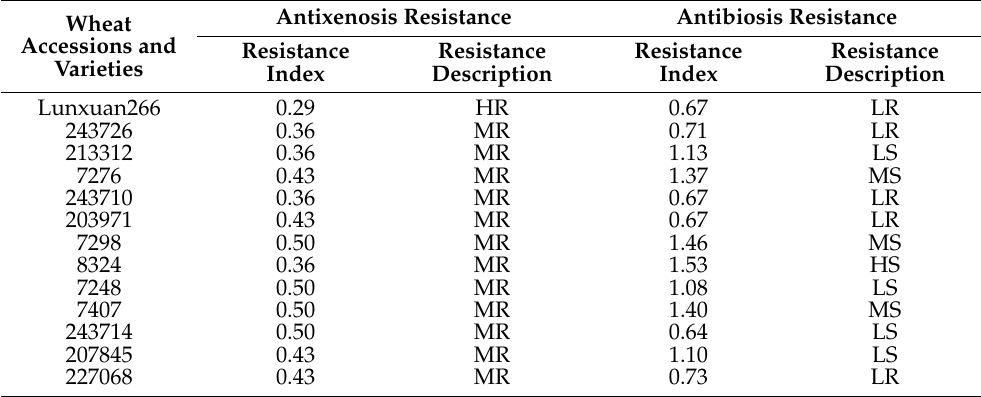
Table 2. Antixenosis and antibiosis resistance index to S. miscanthi for thirteen wheat accessions and varieties. Antixenosis Wheat Accessions and Varieties